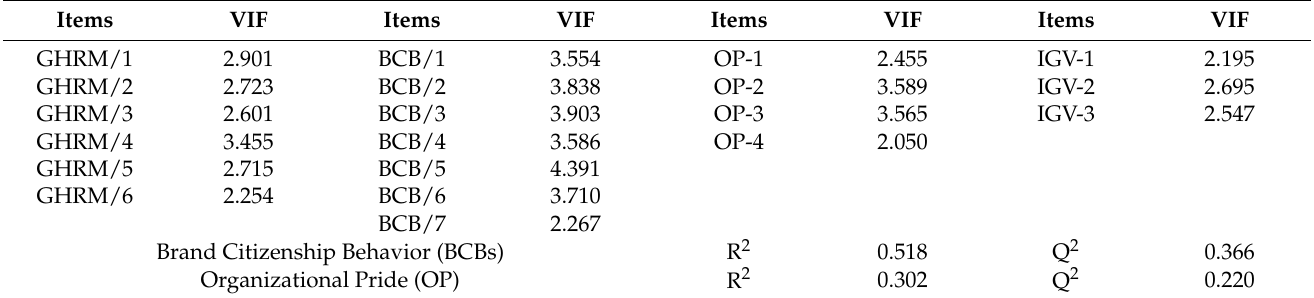
Table 5. VIF, R 2 , and Q 2